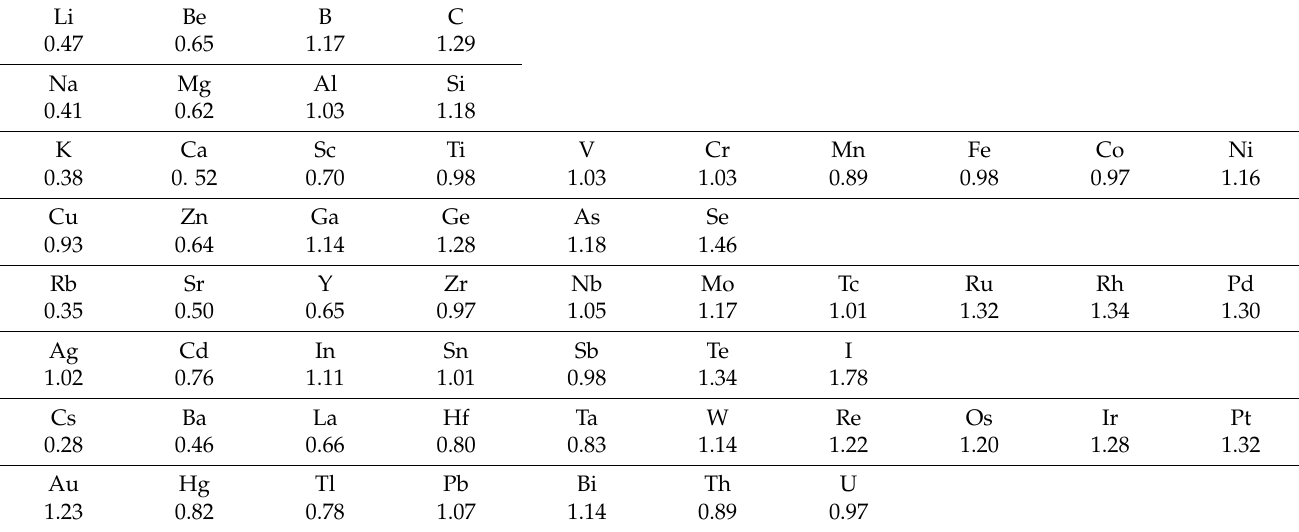
Table 3. Ionization electronegativity ( χ s ) of atoms in solid